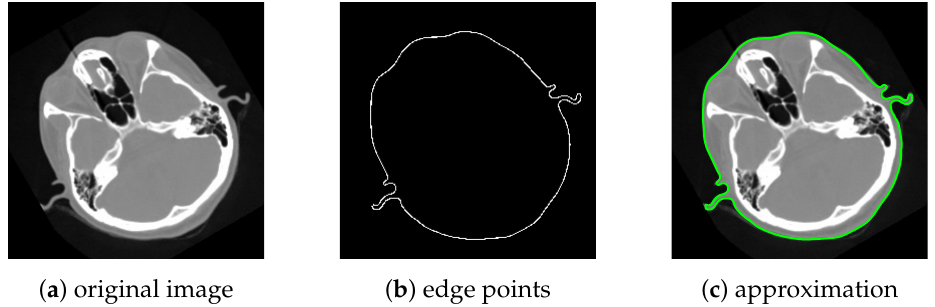
Figure 10. Recognition and approximation of the external profile of a human head. The original image ( a ) is treated to obtain the edge points ( b ), which do not contain cusps in this case; the approximation of the external profile, superimposed to the image, is given in ( c